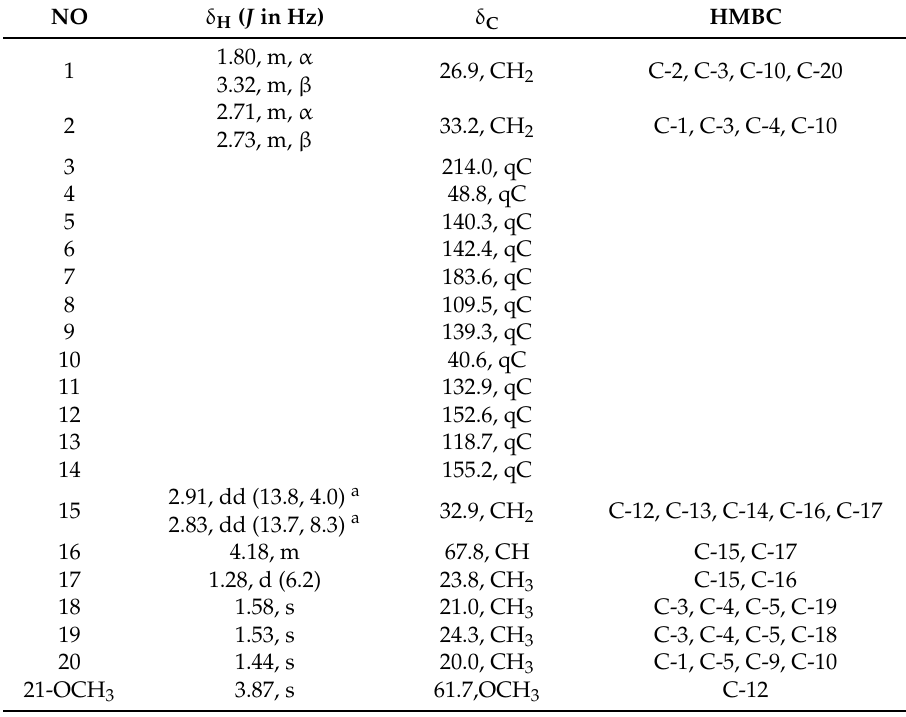
Table 1. NMR spectroscopic data for compound 8 in CDCl 3 .